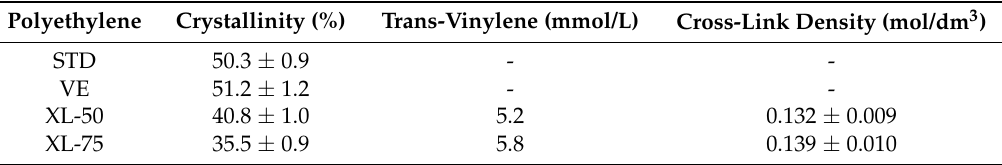
Table 2. Physical–chemical characteristics of the control samples, resulting from FTIR, DSC, and cross-link density measurements.